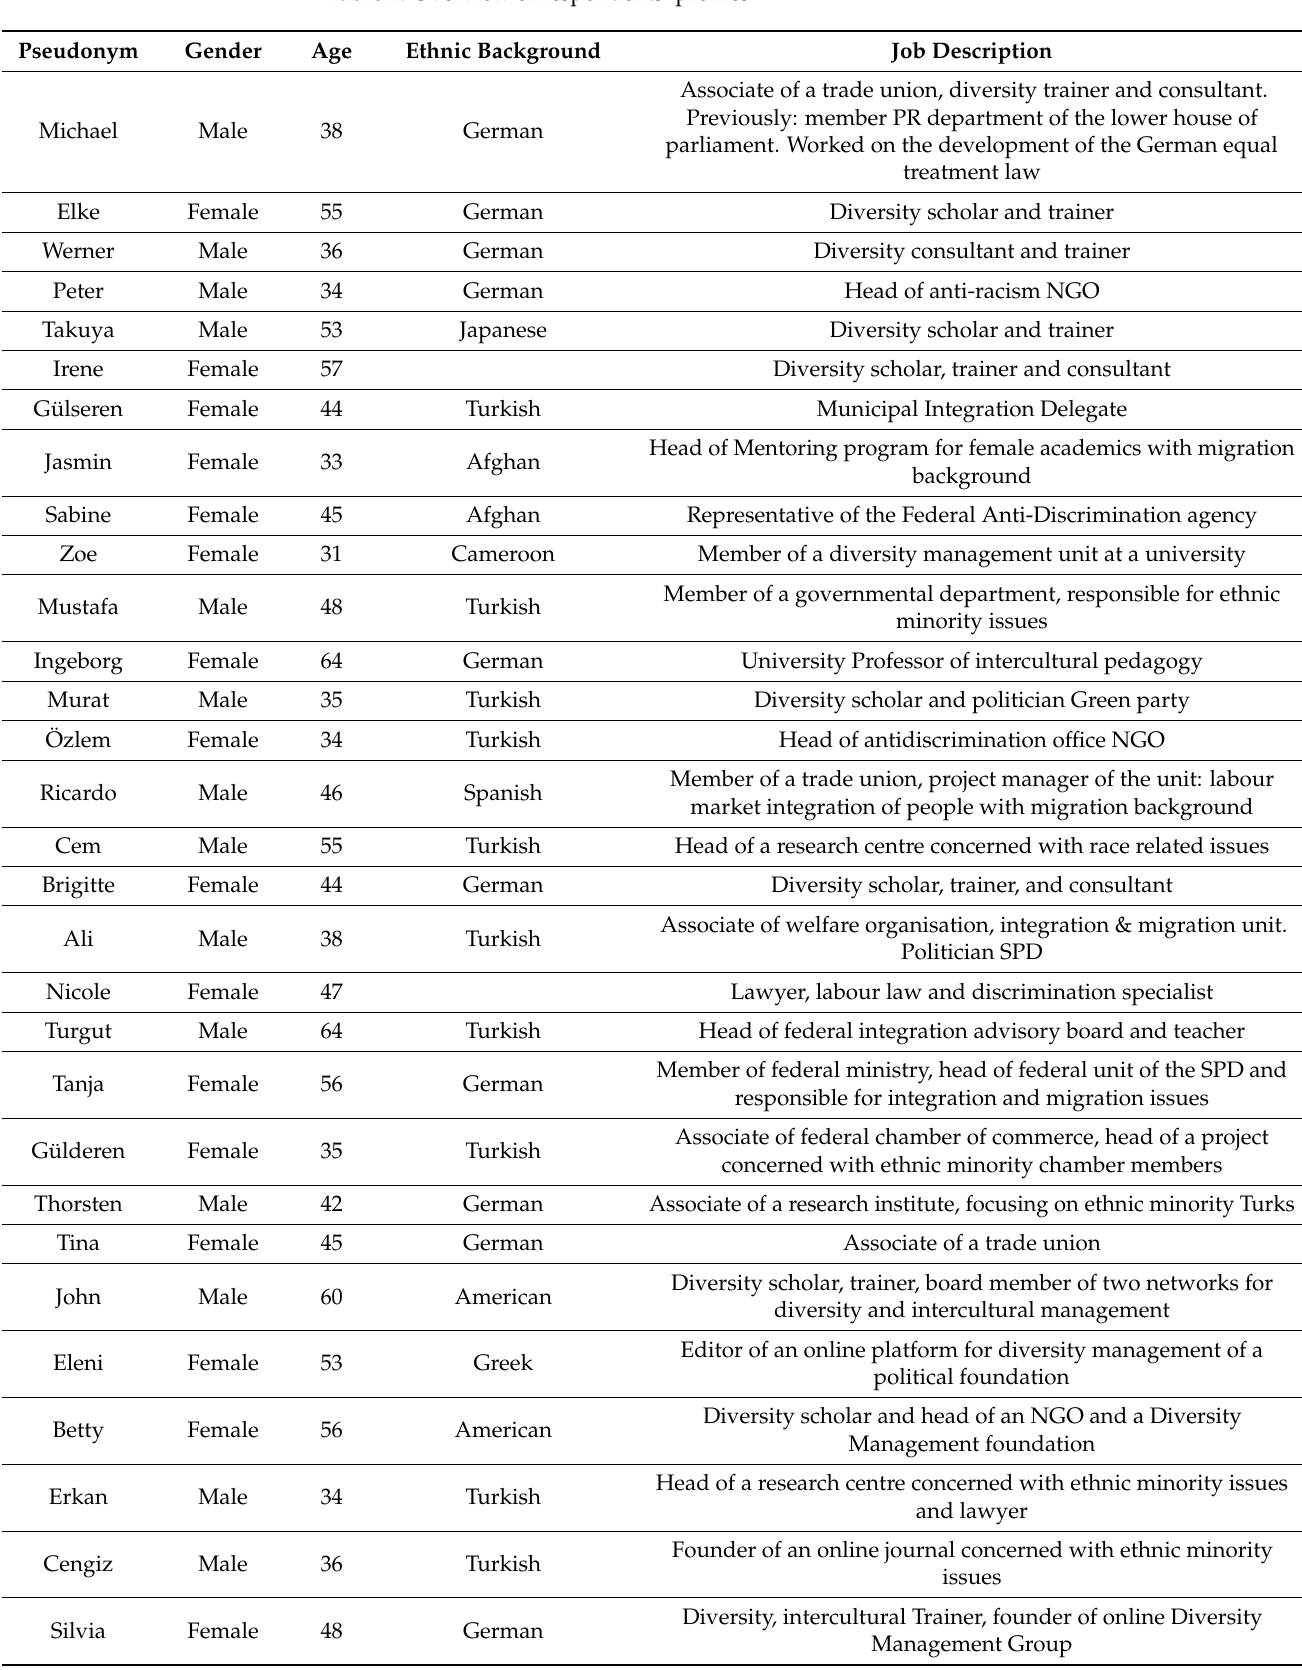
Table 1. Overview of respondents’